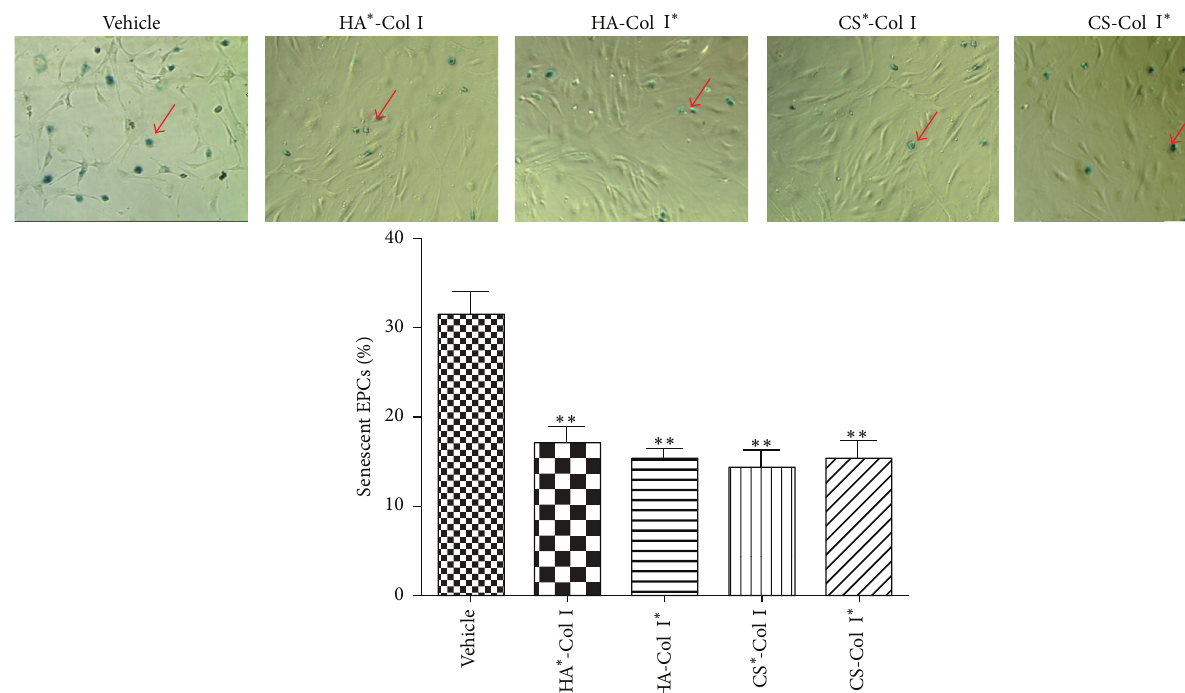
Figure 4: Effects of multilayer composite biomaterial membranes on senescent EPCs. Senescent EPC monitored by 𝛽 -galactosidase staining (red arrows indicating apoptotic cells). ∗∗ 𝑝 < 0.01 versus vehicle, 𝑛 = 3 /group.